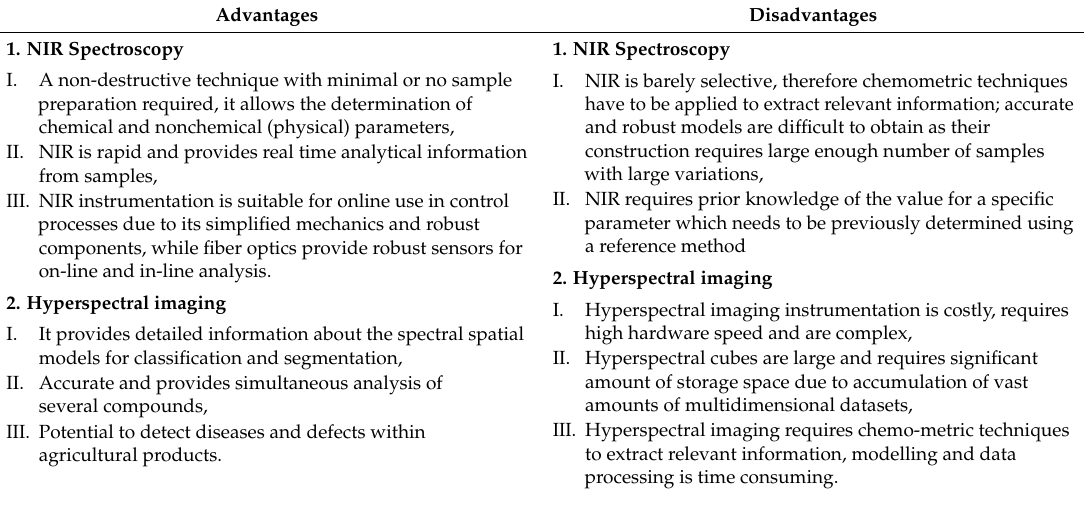
Table 4. The advantages and disadvantages of non-destructive methods for quality evaluation and safety of agricultural and food